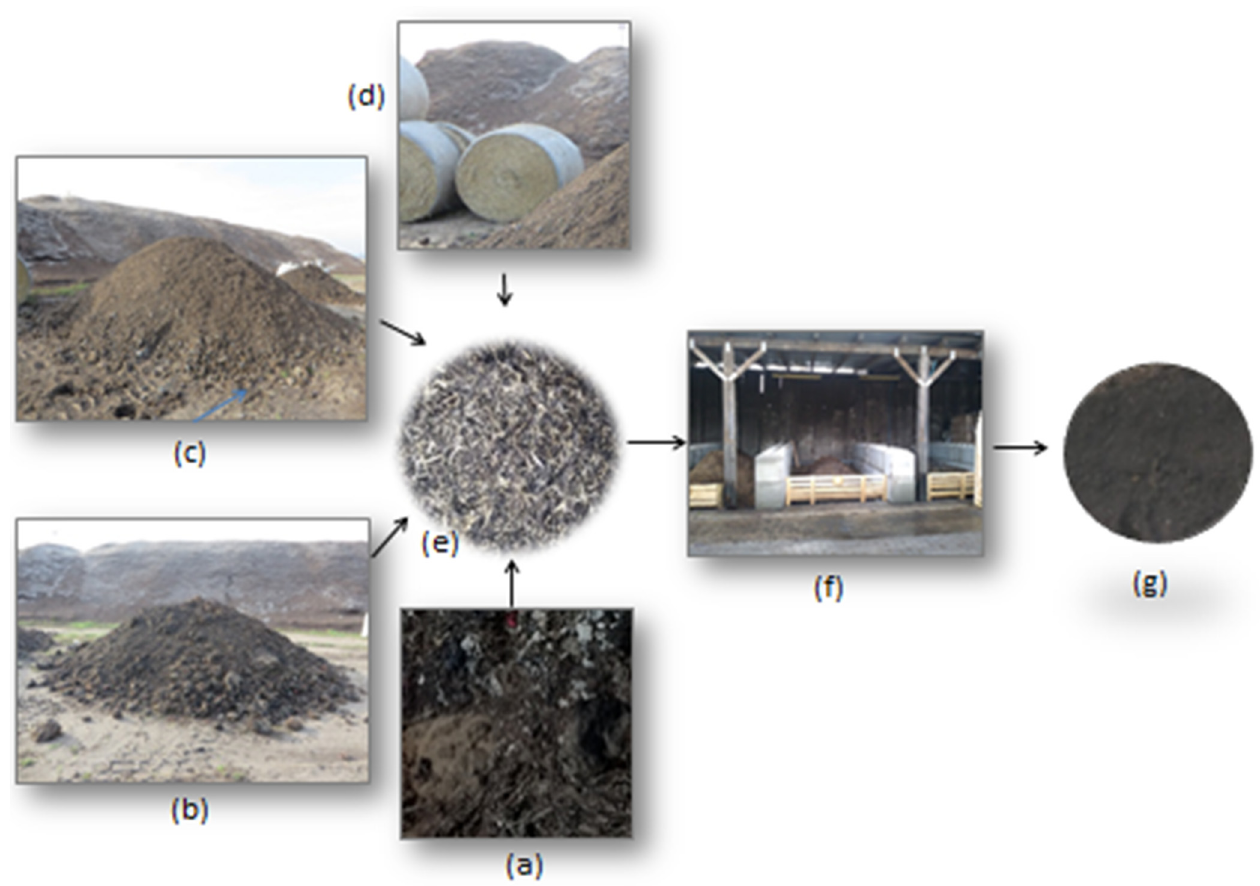
Figure 1. Compost preparation process: ( a ) pulp and paper mill sludge; ( b ) fruit-vegetable waste; ( c ) mushroom spent substrate; ( d ) rye straw; ( e ) compost mixture; ( f ) compost storage site; ( g ) final compost. Table 1. Physical and chemical properties of waste materials used for composting.